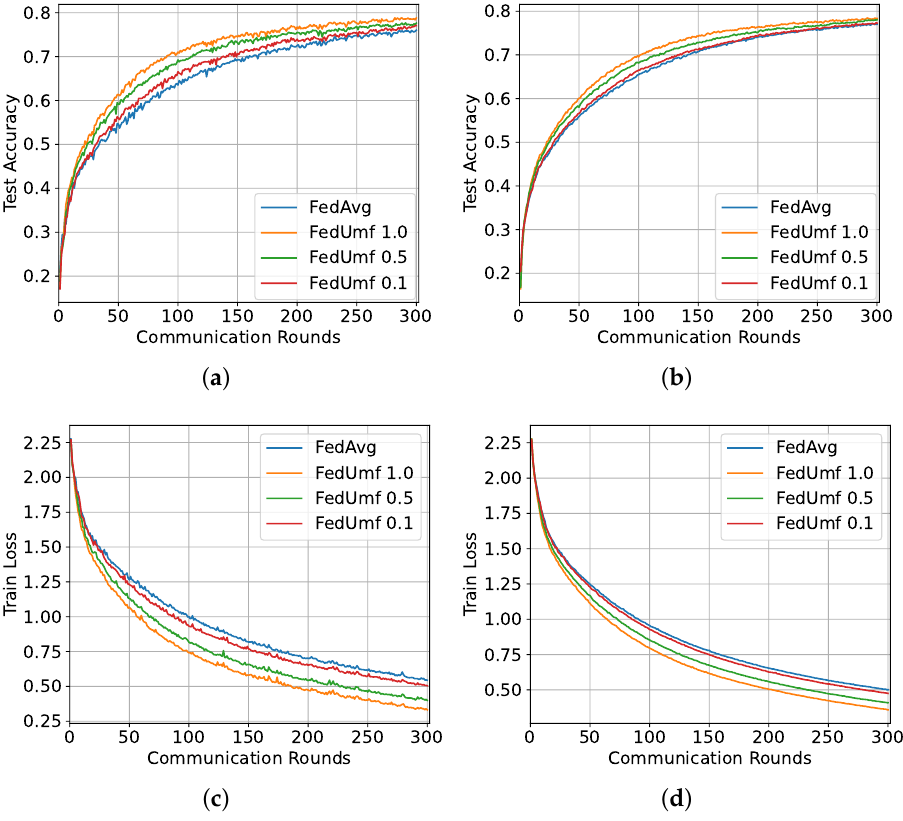
Figure 8. Server test accuracy and client-side training loss curve performance, IID partition and η = 0.05 on CIFAR. ( a ) Test accuracy. C = 0.1. ( b ) Test accuracy. C = 0.5. ( c ) Training loss. C = 0.1. ( d ) Training loss. C = 0.5.